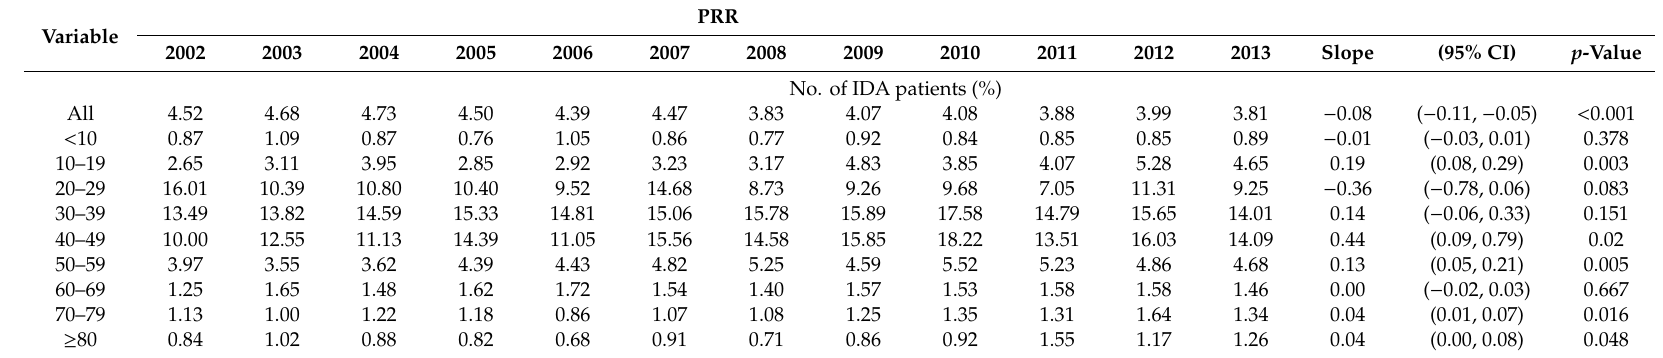
Table 3. Female-to-male prevalence ratios of iron deficiency anemia in the sample cohort population,